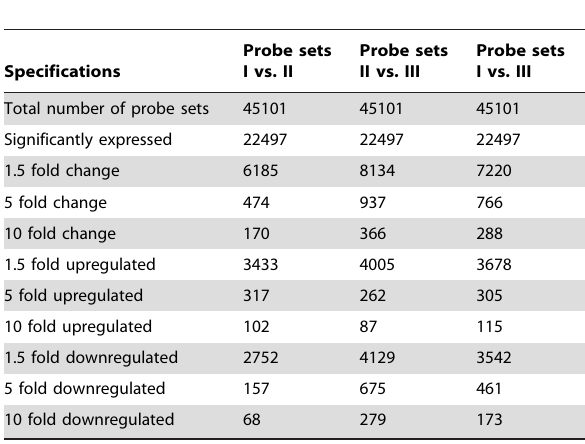
Table 1. Microarray analysis of microdissected embryonic growth plates.